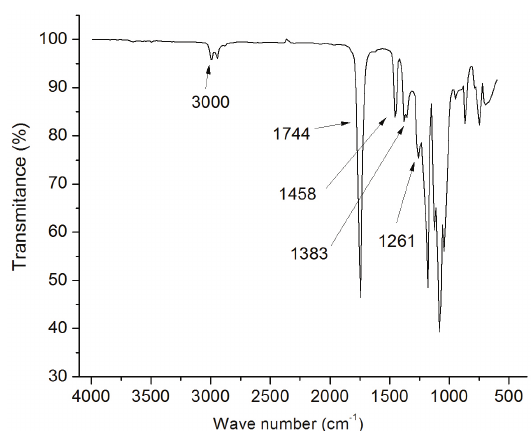
Figure 3. PDLLA FTIR spectrum.